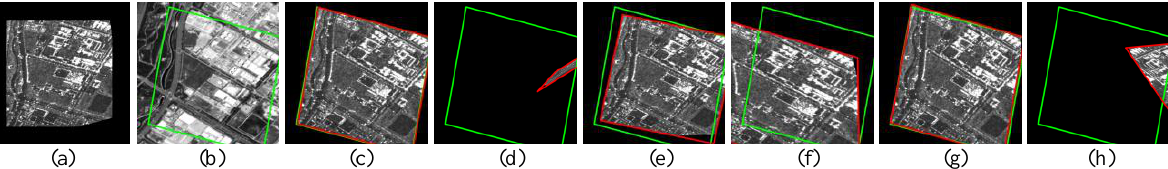
Figure 7. Registration Result of an image pair in Optical-SAR dataset. (a) Randomly affine transformed and cropped sensed image. (b) Reference image. (c) MU-Net. (d) SIFT. (e) RIFT. (f) CFOG. (g) DLKFM. (h) DLIR. The green line represents the ground truth registration result, and the red line represents the experimental registration result for each